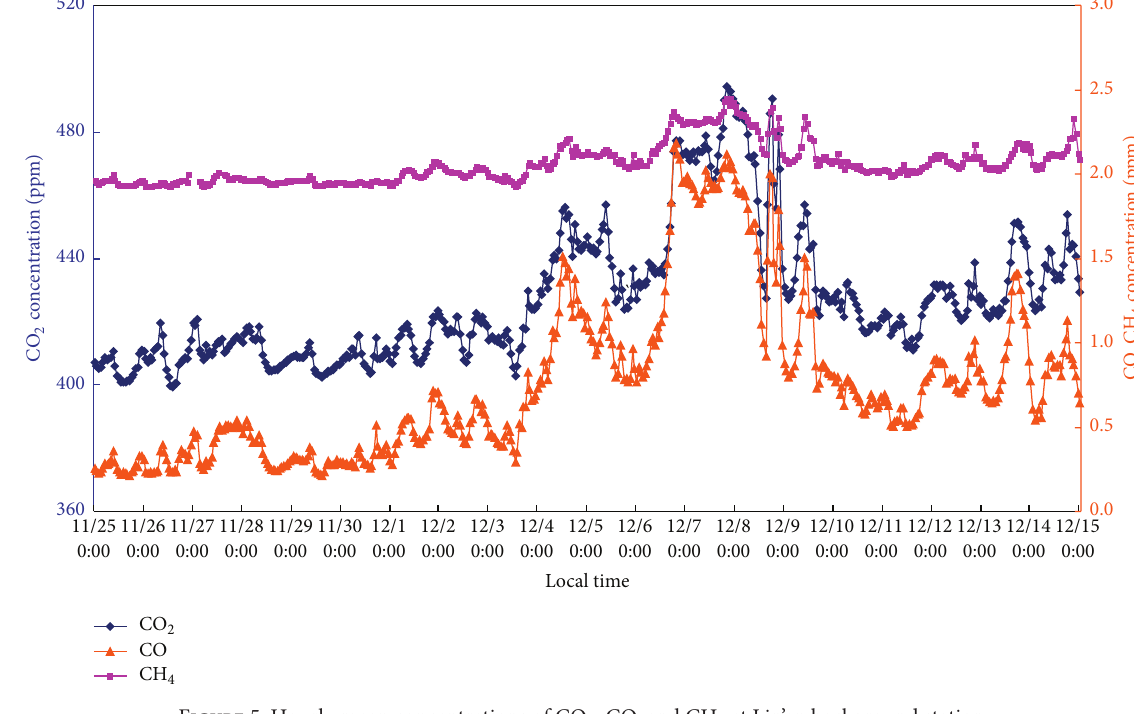
Figure 5: Hourly mean concentrations of CO 2 , CO, and CH 4 at Lin’an background station.